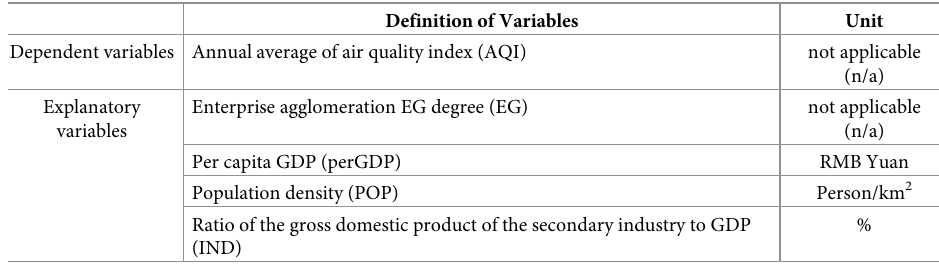
Table 2. Variable definition and